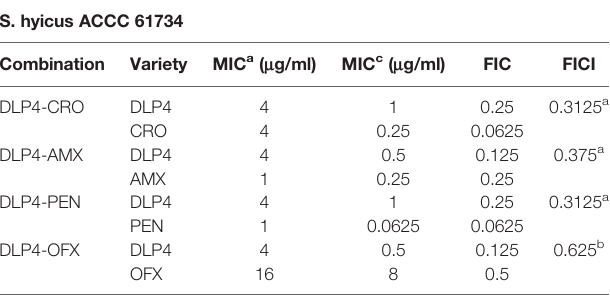
TABLE 2 | The FICI of each combination of different antibiotics with DLP4.